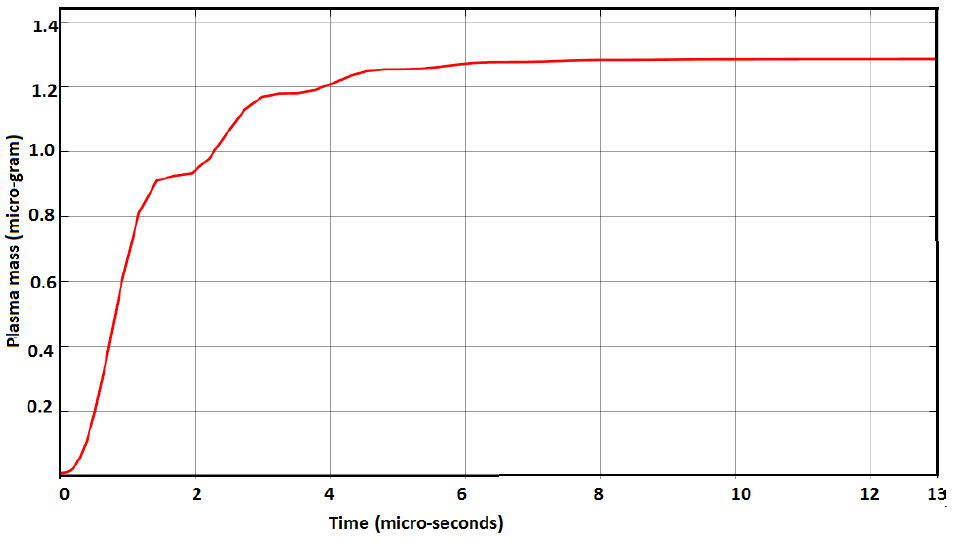
Figure 8. Simulation for plasma mass as a function of time for